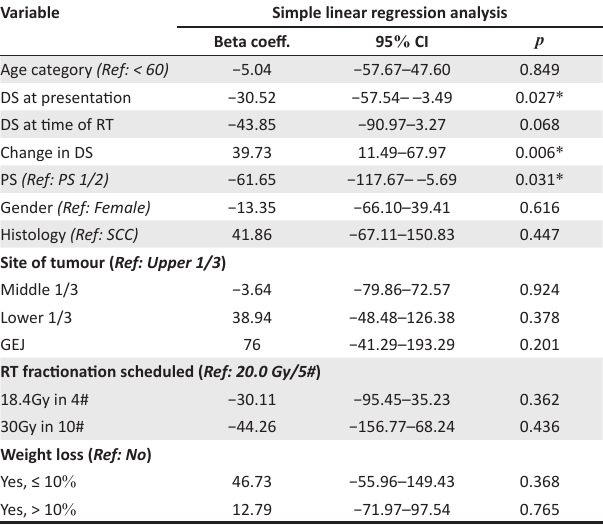
TABLE 5: Simple linear regression analysis for variables associated with post- radiotherapy survival. Variable Simple linear regression